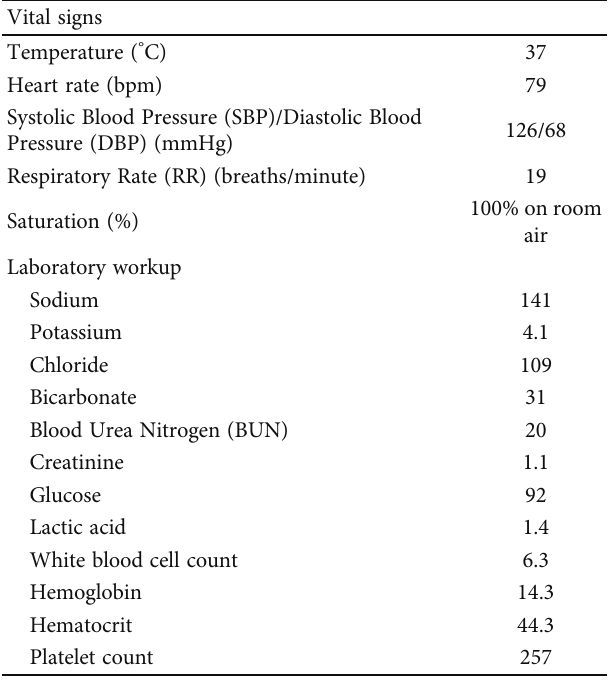
Table 1: Laboratory workup at the time of